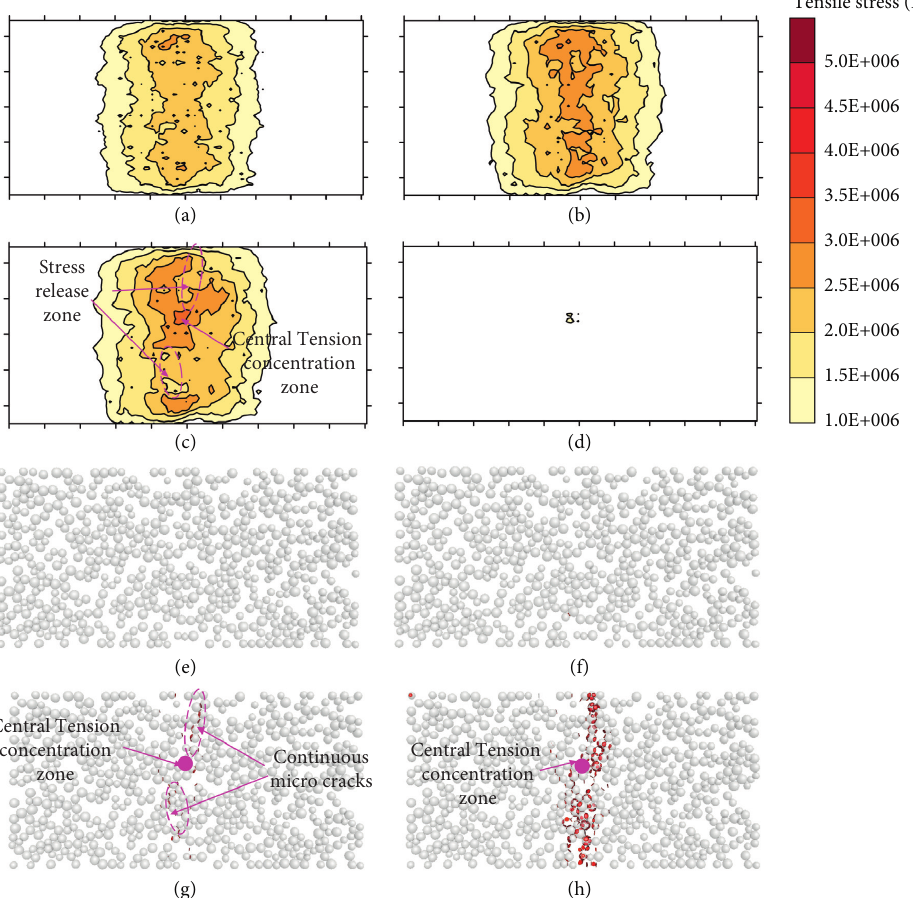
Figure 15: Stress conditions and crack propagations at the monitor points on the horizontal DEF plane for the BT tests: (a–d) stress conditions; (e–h) crack